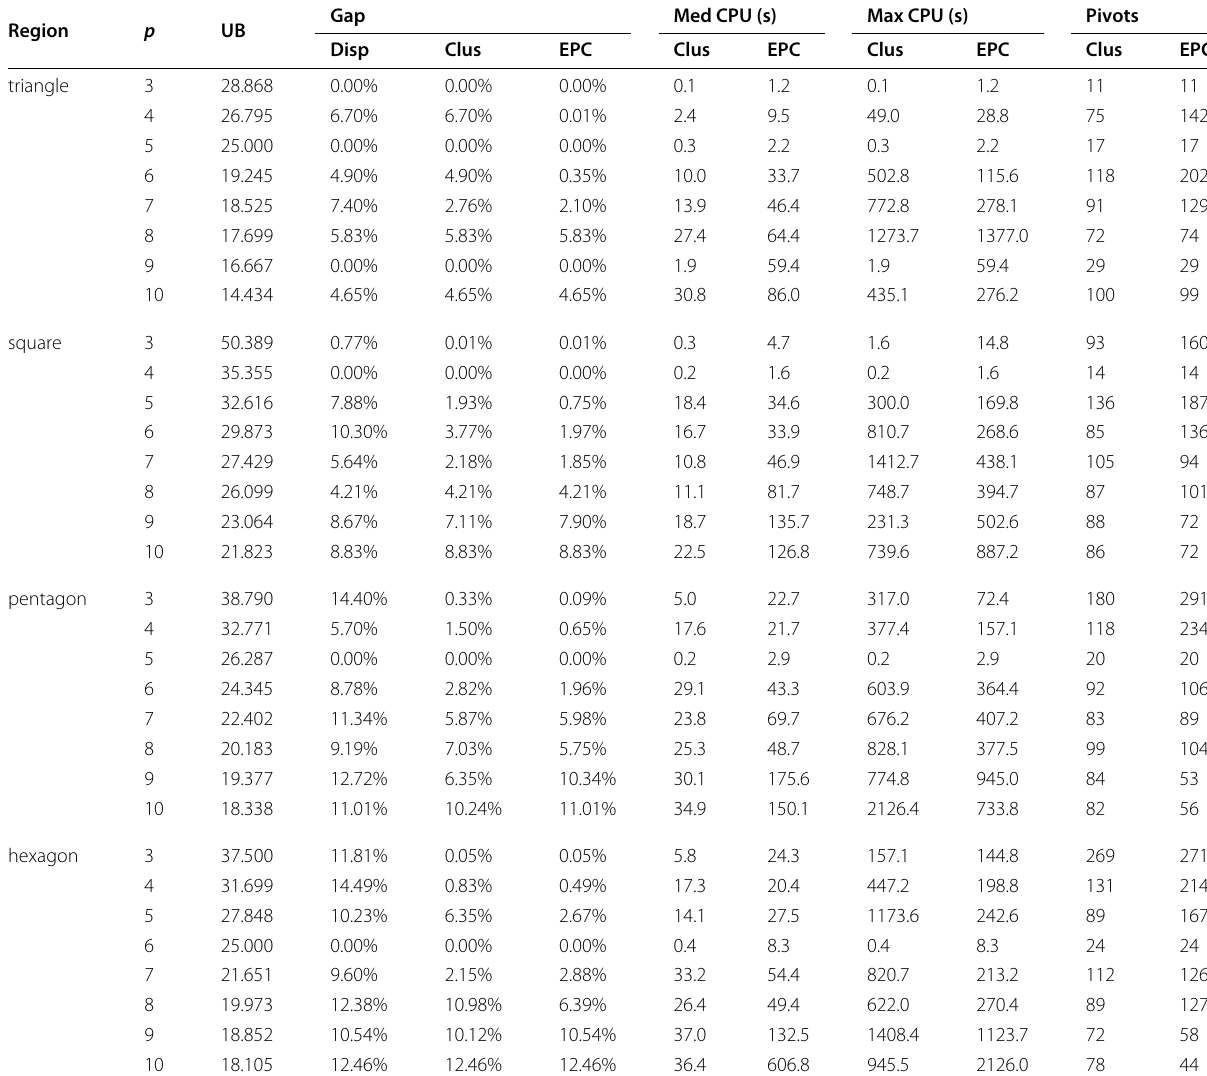
Table 1 Performance achieved by different methods in 2-hour run time for 32 stylized test cases Region p